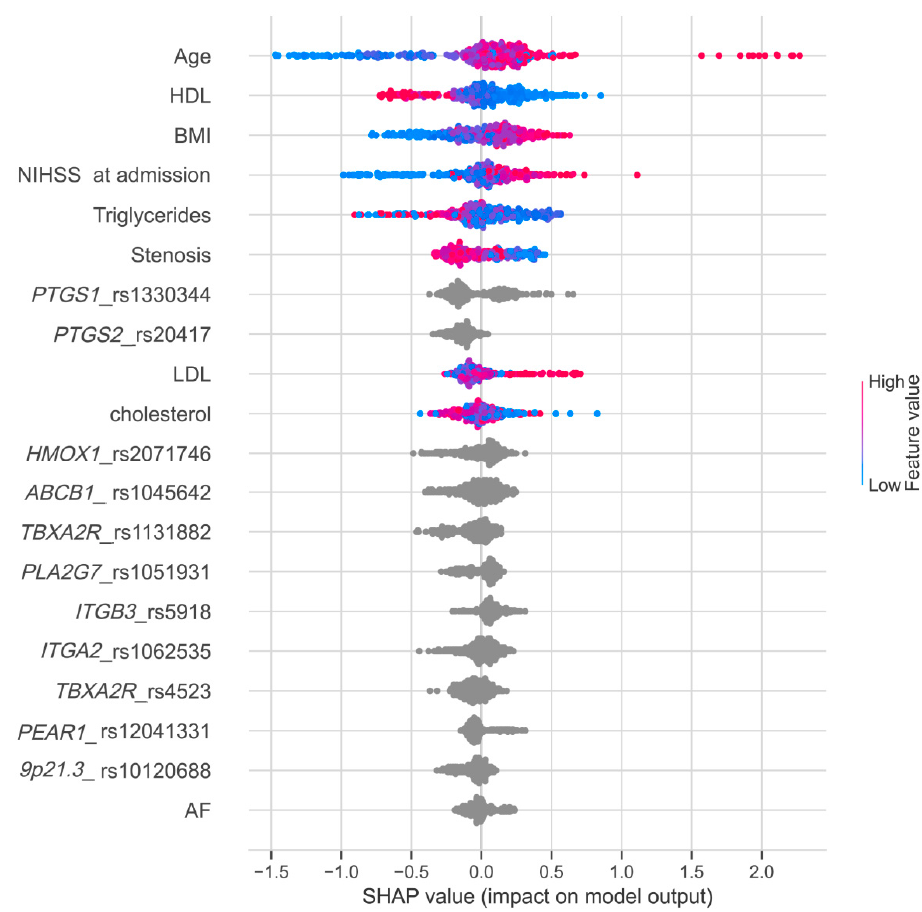
Figure 4. Feature importance ranking obtained using SHAP values. Variables are listed in order of significance from top to bottom on the y -axis. Each point represents a patient, and its color indicates the value of corresponding variable. The position of the points on the x -axis represents SHAP values, indicating the changes in log odds, and the probability of success can be extracted from this